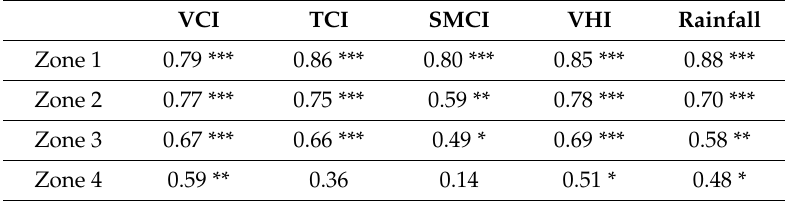
Table 4. Correlation between remote sensing drought indices (VCI, TCI, SMCI and VHI), rainfall amounts during the crop season and crop yield anomalies for the four zones (*, **, *** = significant at 5 / 1 / 0.1% probability